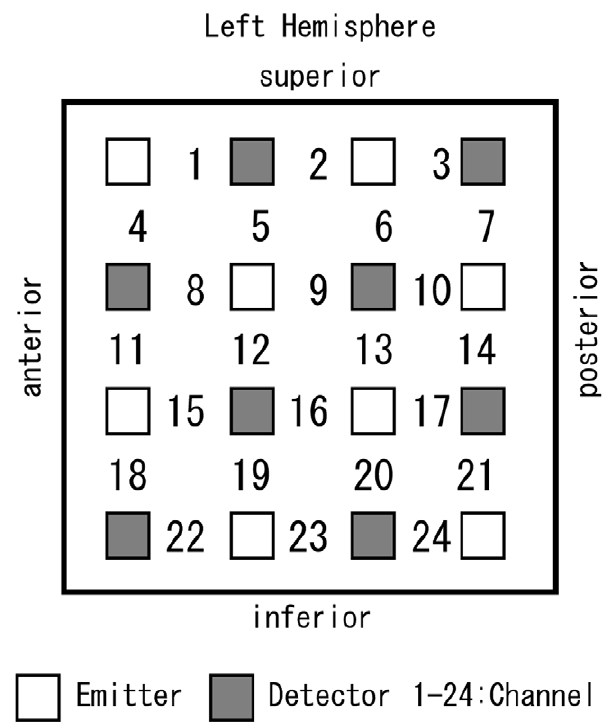
Figure 1. Location of the NIRS optodes placed on the motor areas in the left hemisphere. The distance between each emitter and the corresponding detector was set at 3 cm. C3 was located at the center between channels 9 and